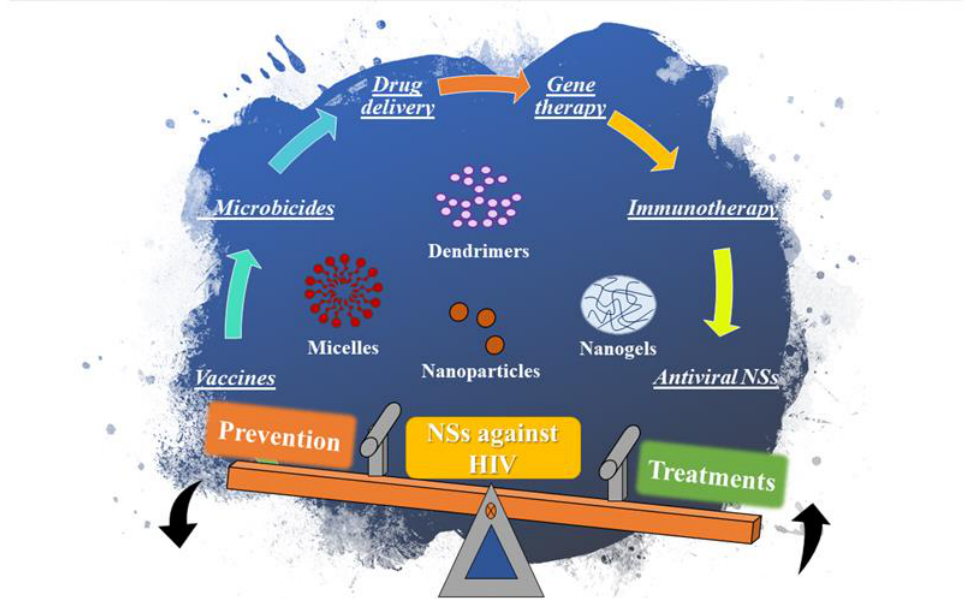
Figure 1. Scheme of the different approaches for prevention and treatment of HIV infections and several NSs described in this review.